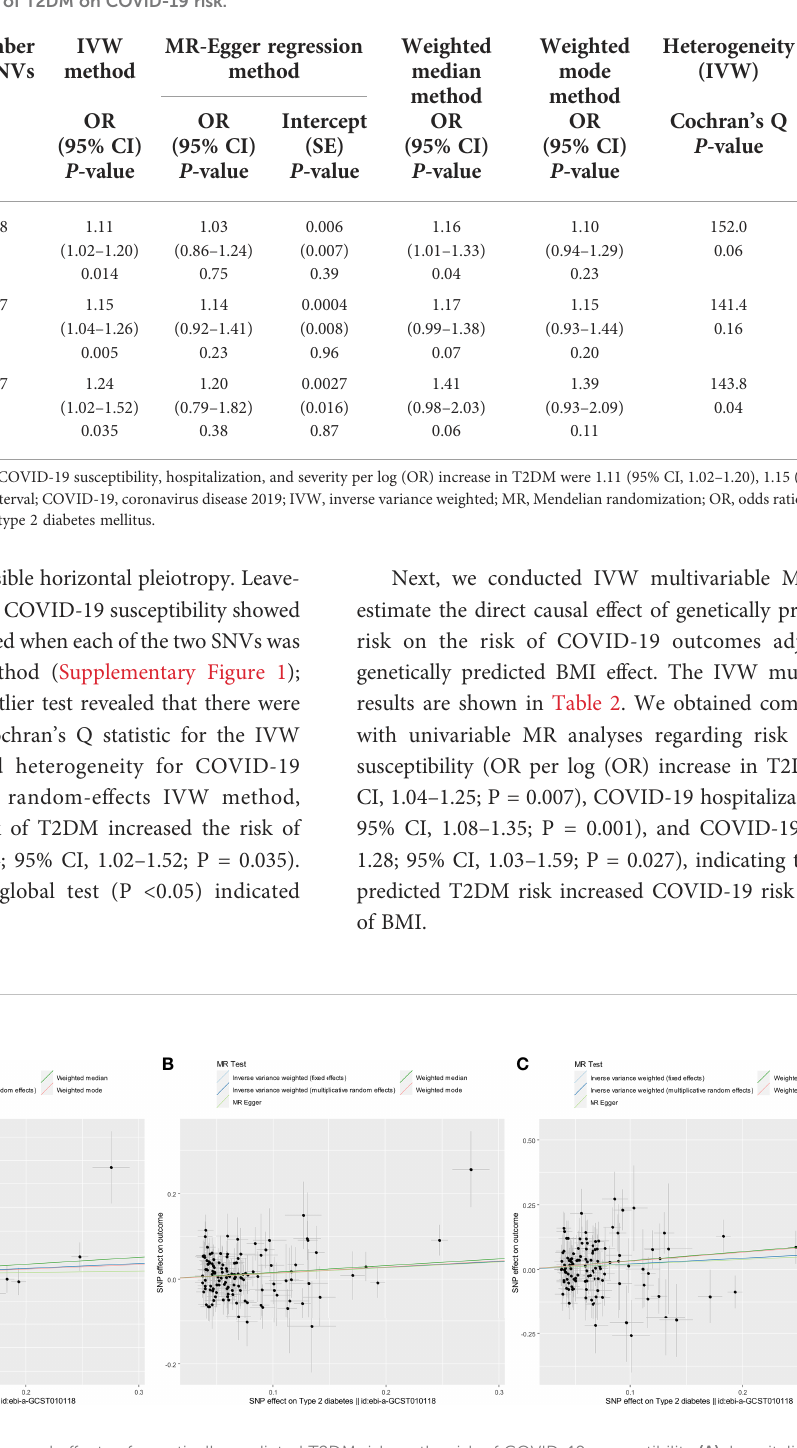
TABLE 1 MR results of the effect of T2DM on COVID-19 risk.